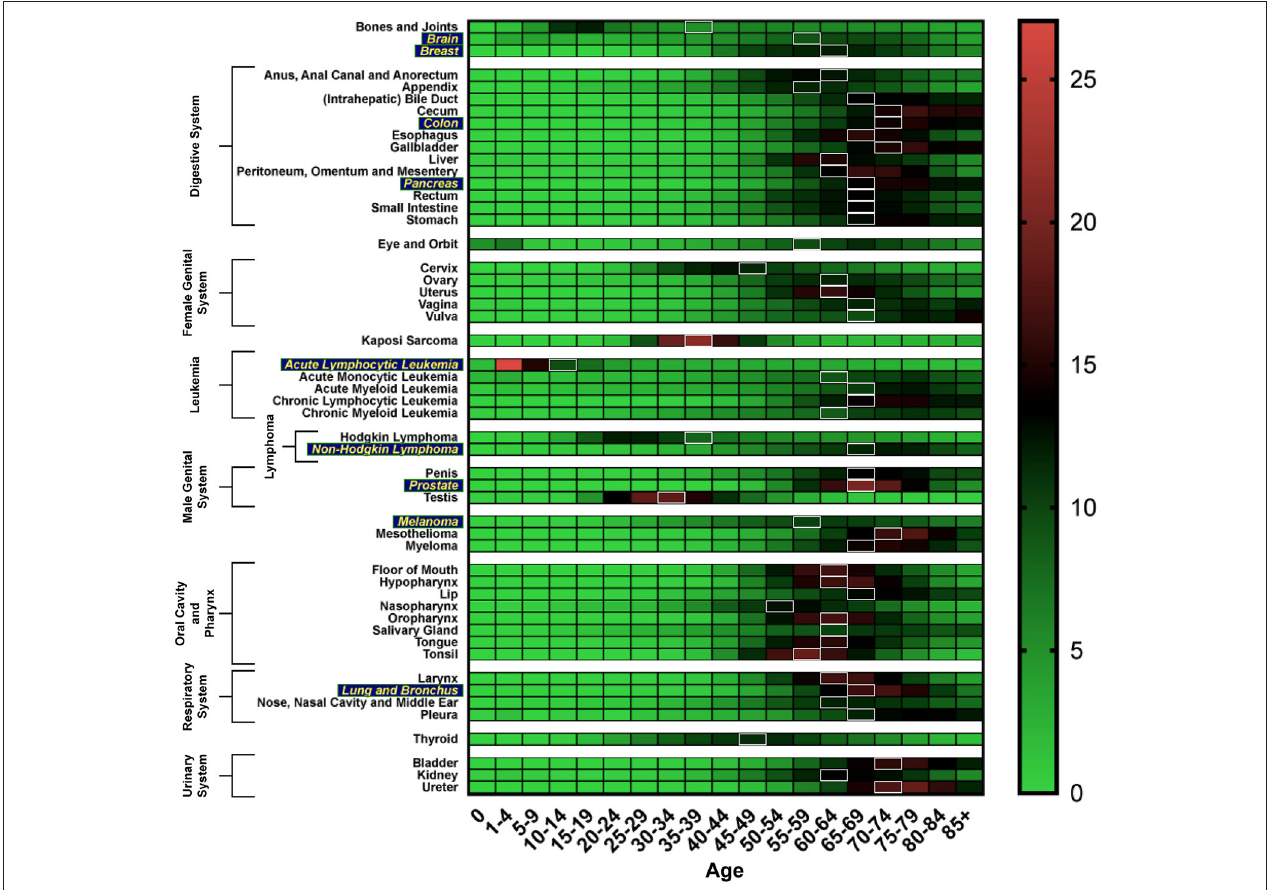
FIGURE 1 | Heat map depicting incidence of cancer diagnosis by age group, analyzed using the SEER database (Howlader et al., 2017). White boxes represent the median age range of cancer incidence. Cancer types more susceptible to the aging-related impact on efficacy of CIT are in